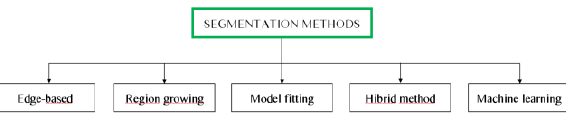
Figure 2. Point cloud segmentation